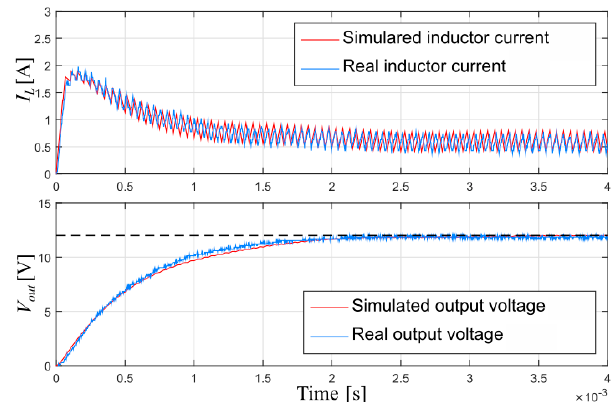
Figure 11. Experimental result using PIDF and the proposed method: inductor current sensor output and converter output signal under reference step variation from 0 V to 12 V.